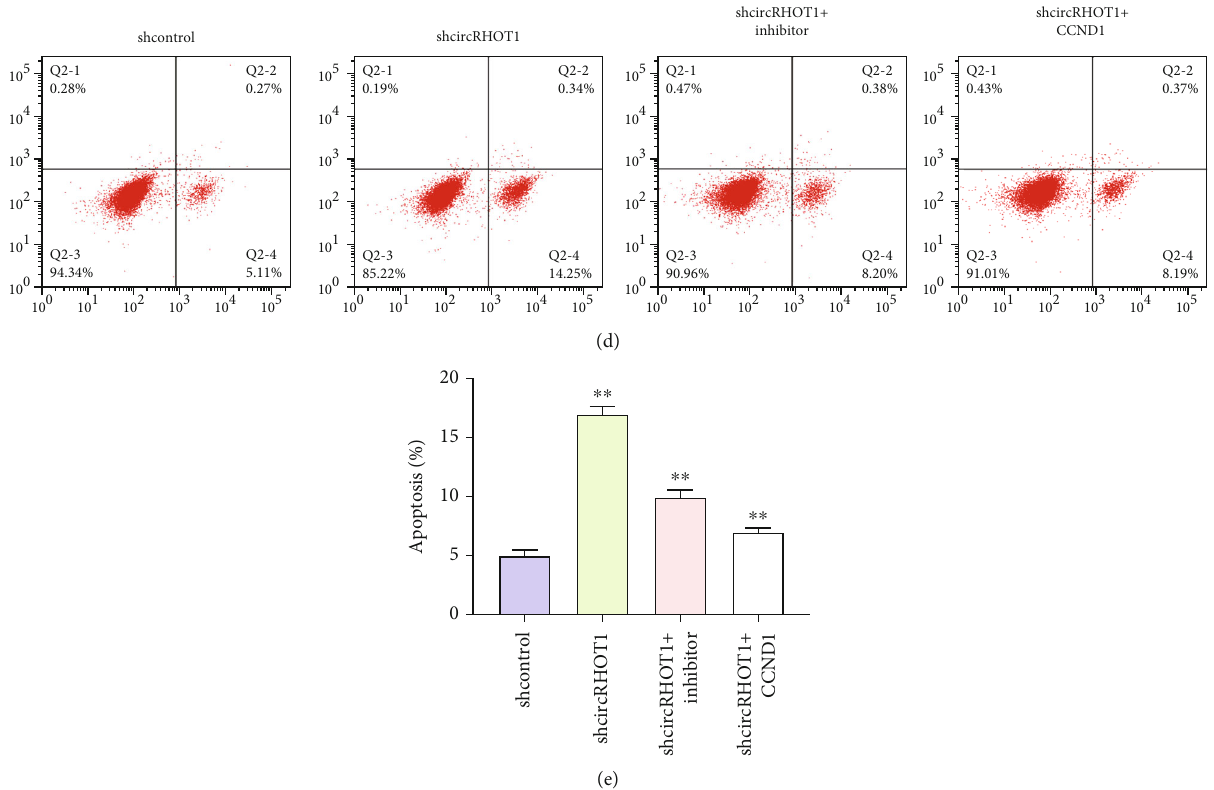
Figure 6: CircRHOT1 contributes to the proliferation of chondrocytes by targeting the miR-142-5p/CCND1 axis. (a) – (e) The chondrocytes were treated with circRHOT1 shRNA or cotreated with circRHOT1 shRNA and CCND1 overexpressing plasmid or miR-142-5p inhibitor. (a) The cell viability was detected by CCK-8 assays. (b, c) The cell proliferation was analyzed by colony formation assays. Magni fi cation, × 20. (d, e) The cell apoptosis was assessed by FACS fl ow cytometer. Mean ± SD , ∗∗ P < 0 : 01